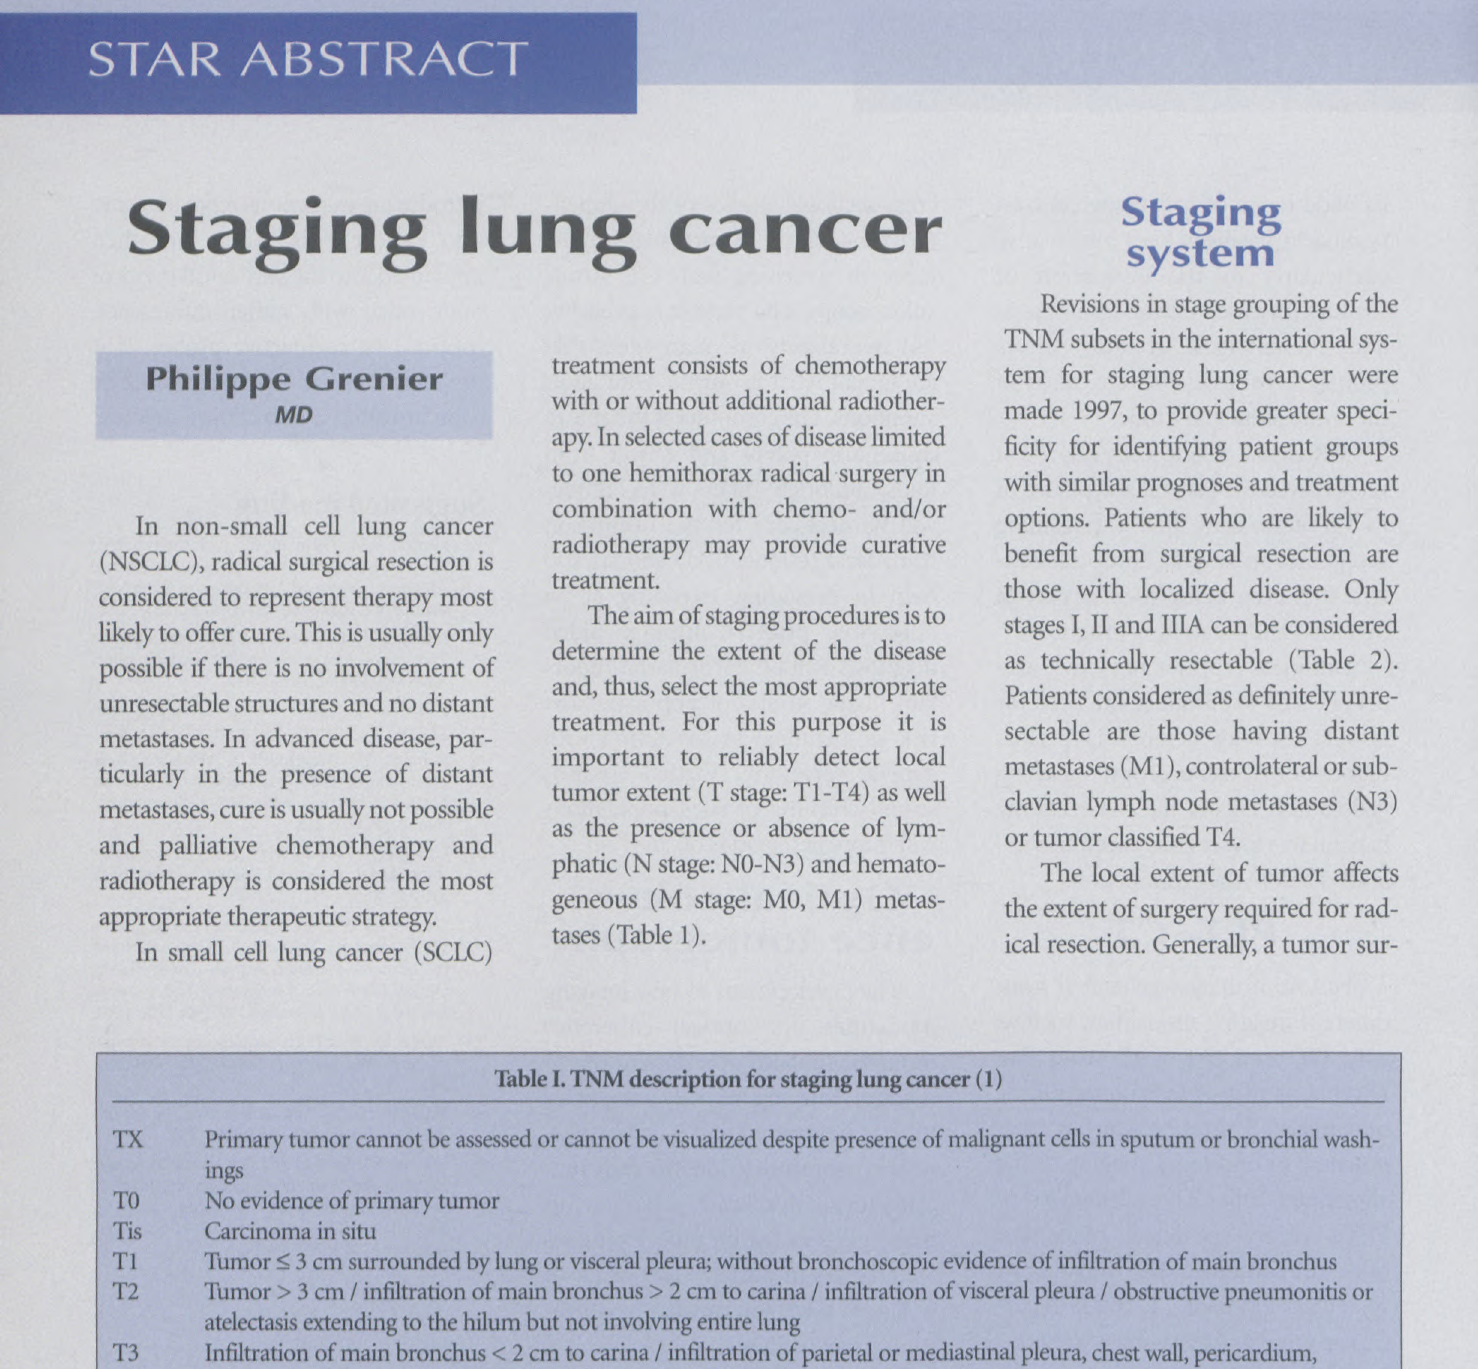
Table I. TNM description for staging lung cancer